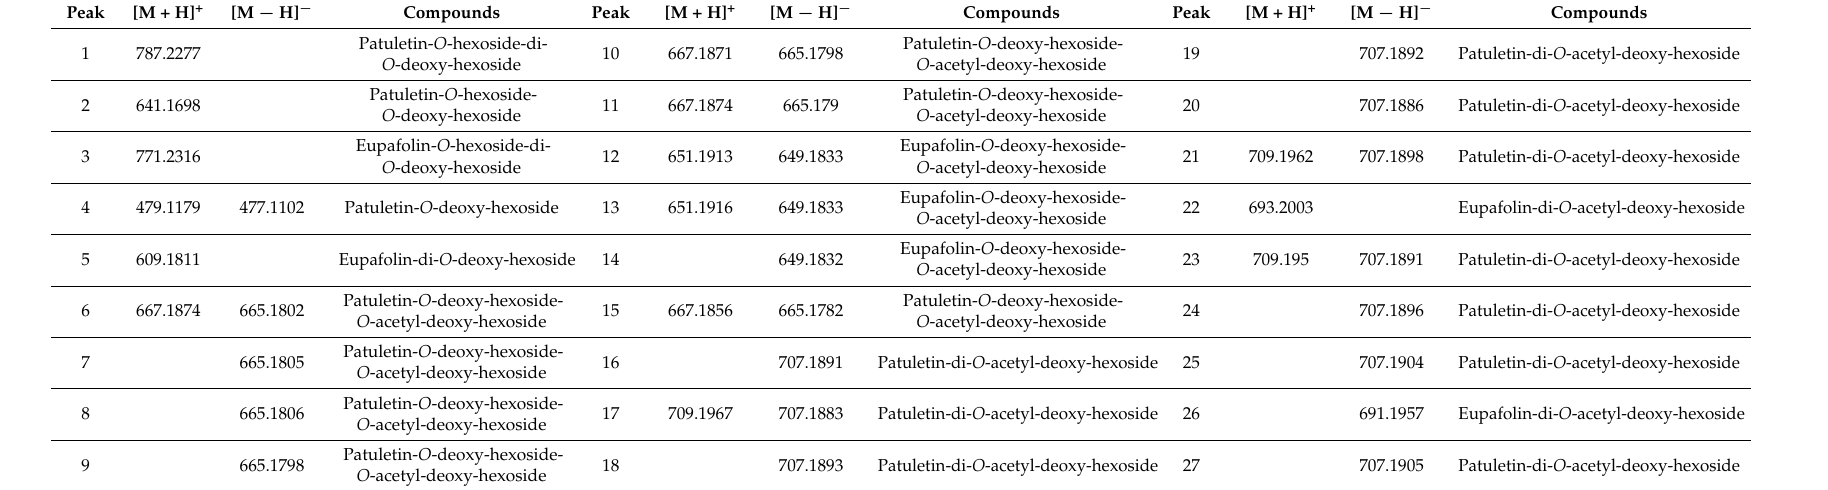
Table 1. Compounds identified by UHPLC-MS in Kalanchoe brasiliensis leaf juice.